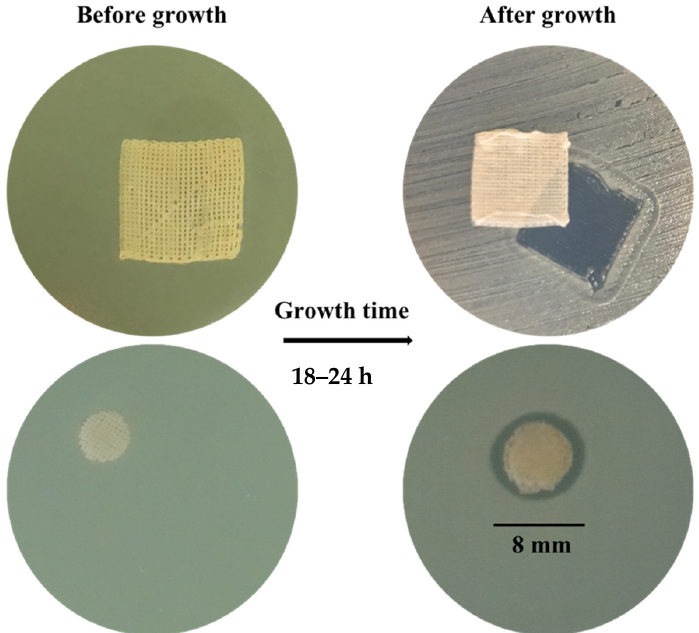
Figure 8. Photographs representing test samples (entire scaffold); VitE 1 on Staphilococcus aureus.